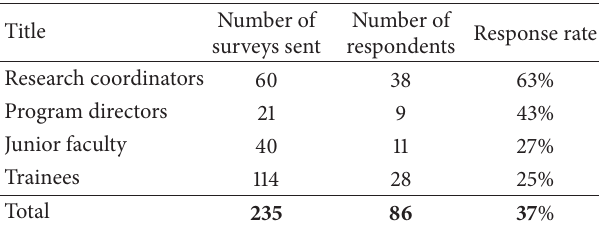
Table 1: Number of survey respondents, response rate, and total response rate based on identified position.